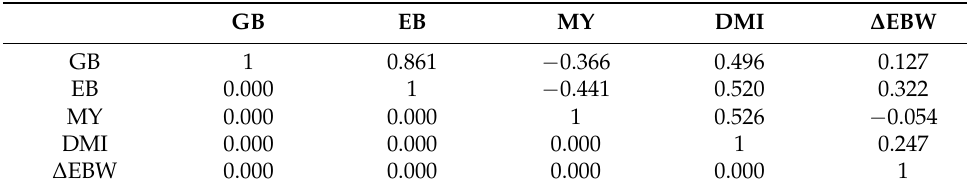
Table 4. Pearson correlation coefficients (upper side) and their p -values (lower side) for weekly means of glucose balance (GB), energy balance (EB), dry matter intake (DMI), milk yield (MY), and the weekly change in empty body weight ( ∆ EBW) across all lactation weeks investigated. GB EB MY DMI ∆ EBW GB 1 0.861 − 0.366 0.496 0.127 EB 0.000 1 − 0.441 0.520 0.322 MY 0.000 0.000 1 0.526 − 0.054 DMI 0.000 0.000 0.000 1 0.247 ∆ EBW 0.000 0.000 0.000 0.000